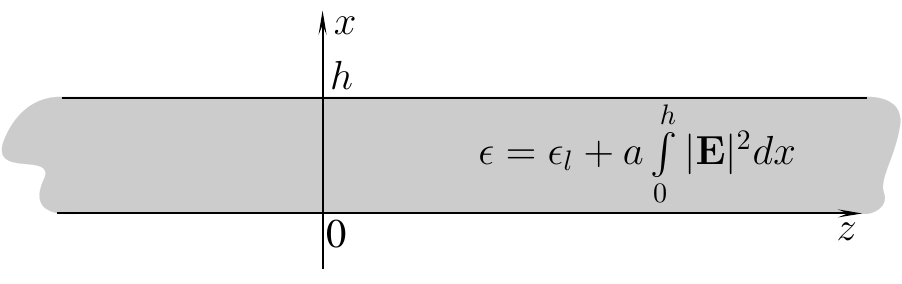
Figure 1. Geometry of the